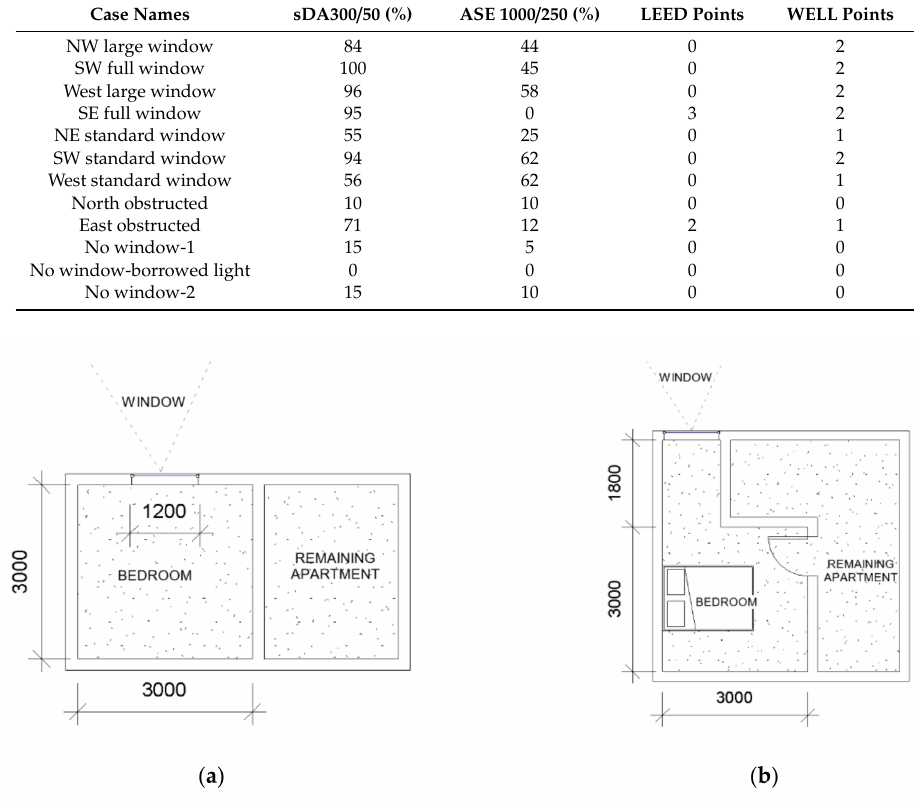
Figure 7. ( a ) Bedroom with standard layout. ( b ) Snorkel